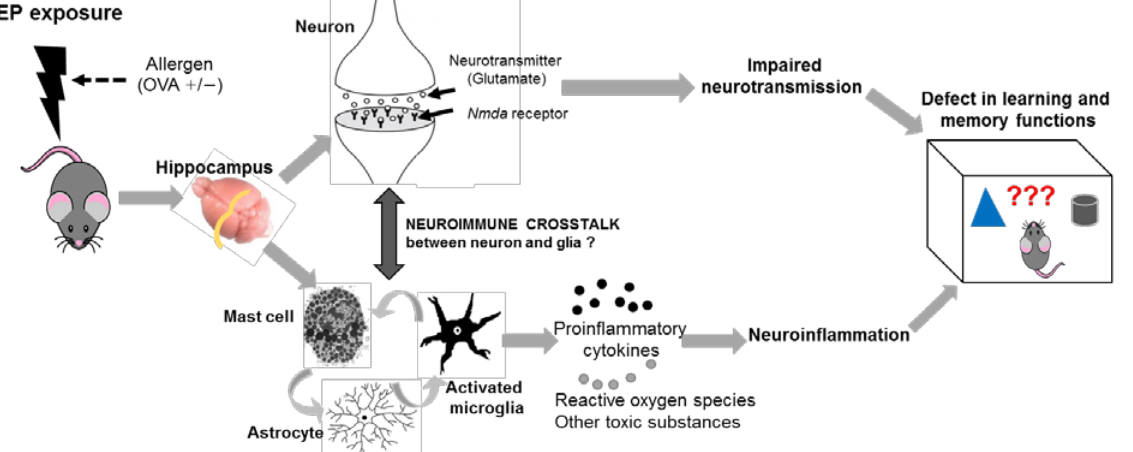
Figure 11. Diagram of summarized results of TBEP-induced neurotoxicity. Dietary exposure to TBEP could impair memory function accompanied by abnormal activation of Nmda receptor subunits and induced neuroinflammation via upregulation of proinflammatory cytokines and oxidative stress markers in mice with or without OVA immunization. Increased expression of mast cells and glial cells (microglia and astrocytes) activation was observed in an allergic asthmatic mouse model. Neuroimmune crosstalk between neurons, immune cells such as mast cells, and glial cells (microglia and astrocyte) inflammatory molecules might play a key role in response to environmental chemical-induced neurobehavioral